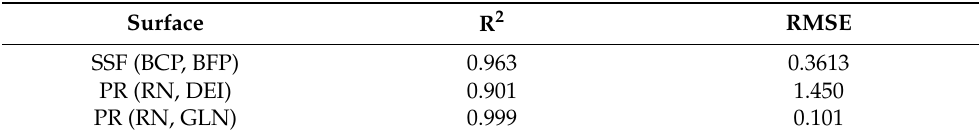
Table 7. Parametric surface goodness-of-fits.